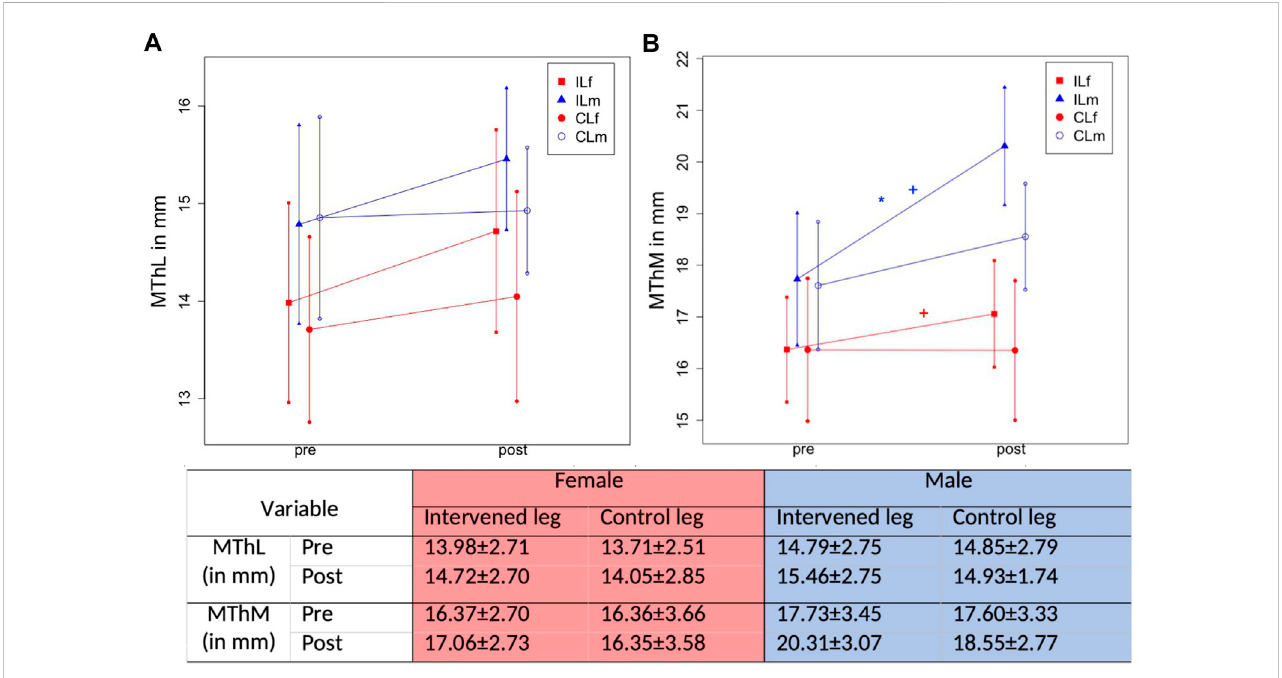
FIGURE 7 Graphical illustration of progression in MTh in IL and CL due to 1-h daily stretching training in plantar fl exor in MThL (muscle thickness in the lateral head ofthegastrocnemius) (A) andMThM(musclethicknessinthemedialheadofthegastrocnemius) (B) consideringsex.The*illustratesasigni fi cantdifferenceto the control leg, the + illustrates a signi fi cant difference to the other sex.